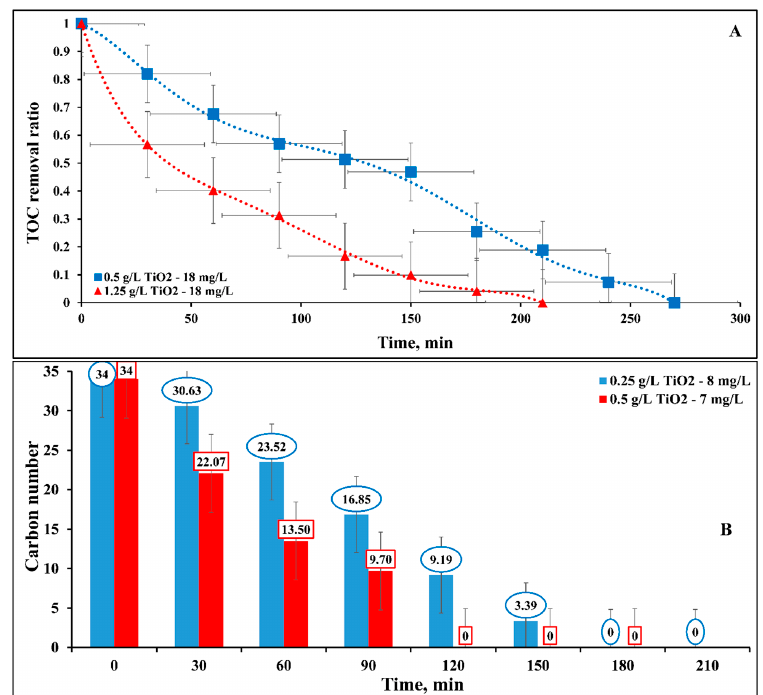
Figure 12. ( A , B ) Influence of catalyst loading on DB15 mineralization at natural pH, light intensity 11.2 W/m 2 , and different dye concentrations.